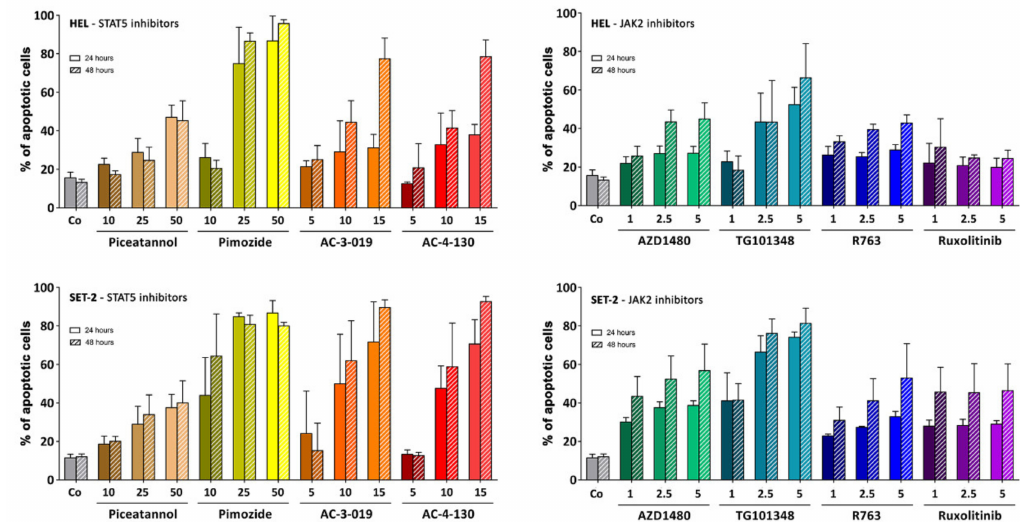
Figure A4. HEL and SET-2 cells (as indicated) were incubated with di ff erent concentrations of JAK2 or STAT5 targeting drugs for 24 h or 48 h at 37 ◦ C. Thereafter, apoptosis induction was assessed using Annexin V / propidium iodide (PI) staining. The columns show the sum of cells positive for Annexin V-only, PI-only or Annexin V / PI for each condition and are depicted as mean ± SD of at least three independent experiments.